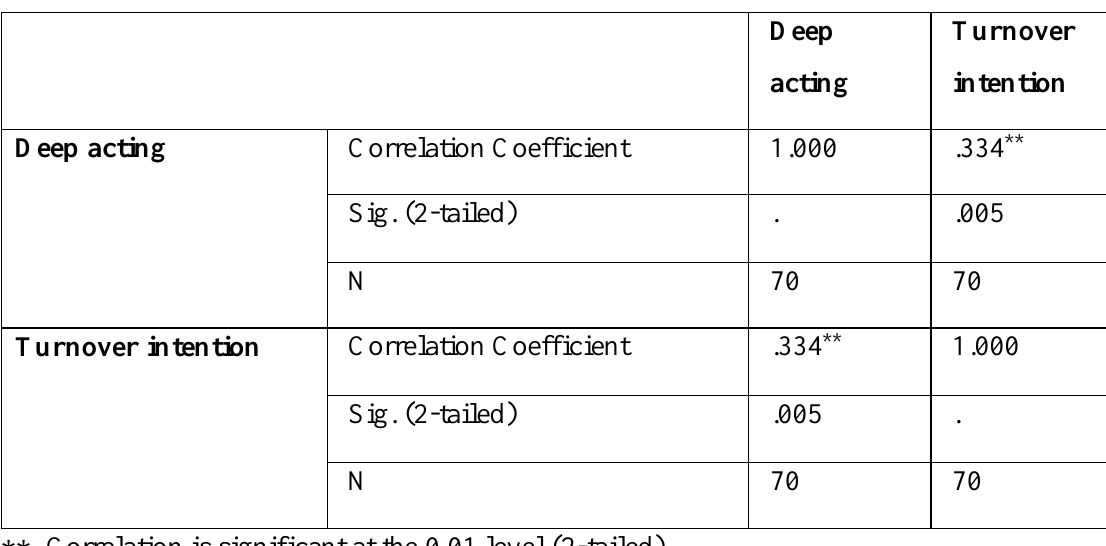
Table 5: Correlation between Deep Acting and Turnover Intention